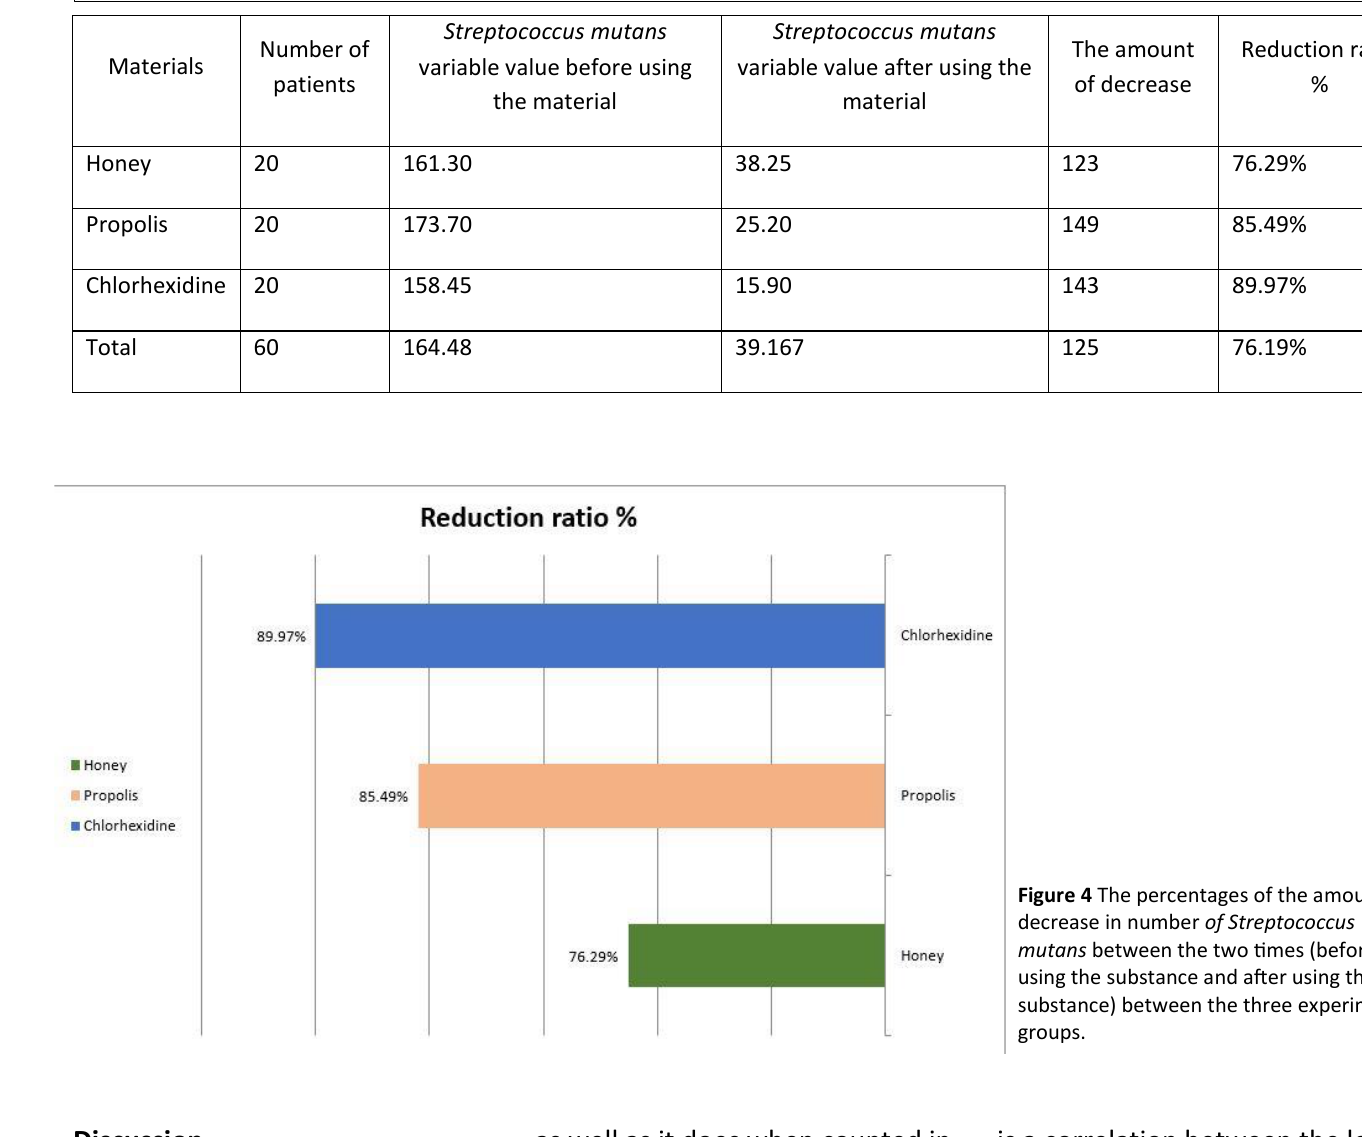
Table No. 3. The percentages of the amount of decrease in number of Streptococcus mutans between the two times (before using the substance and after using the substance) between the three experimental groups.